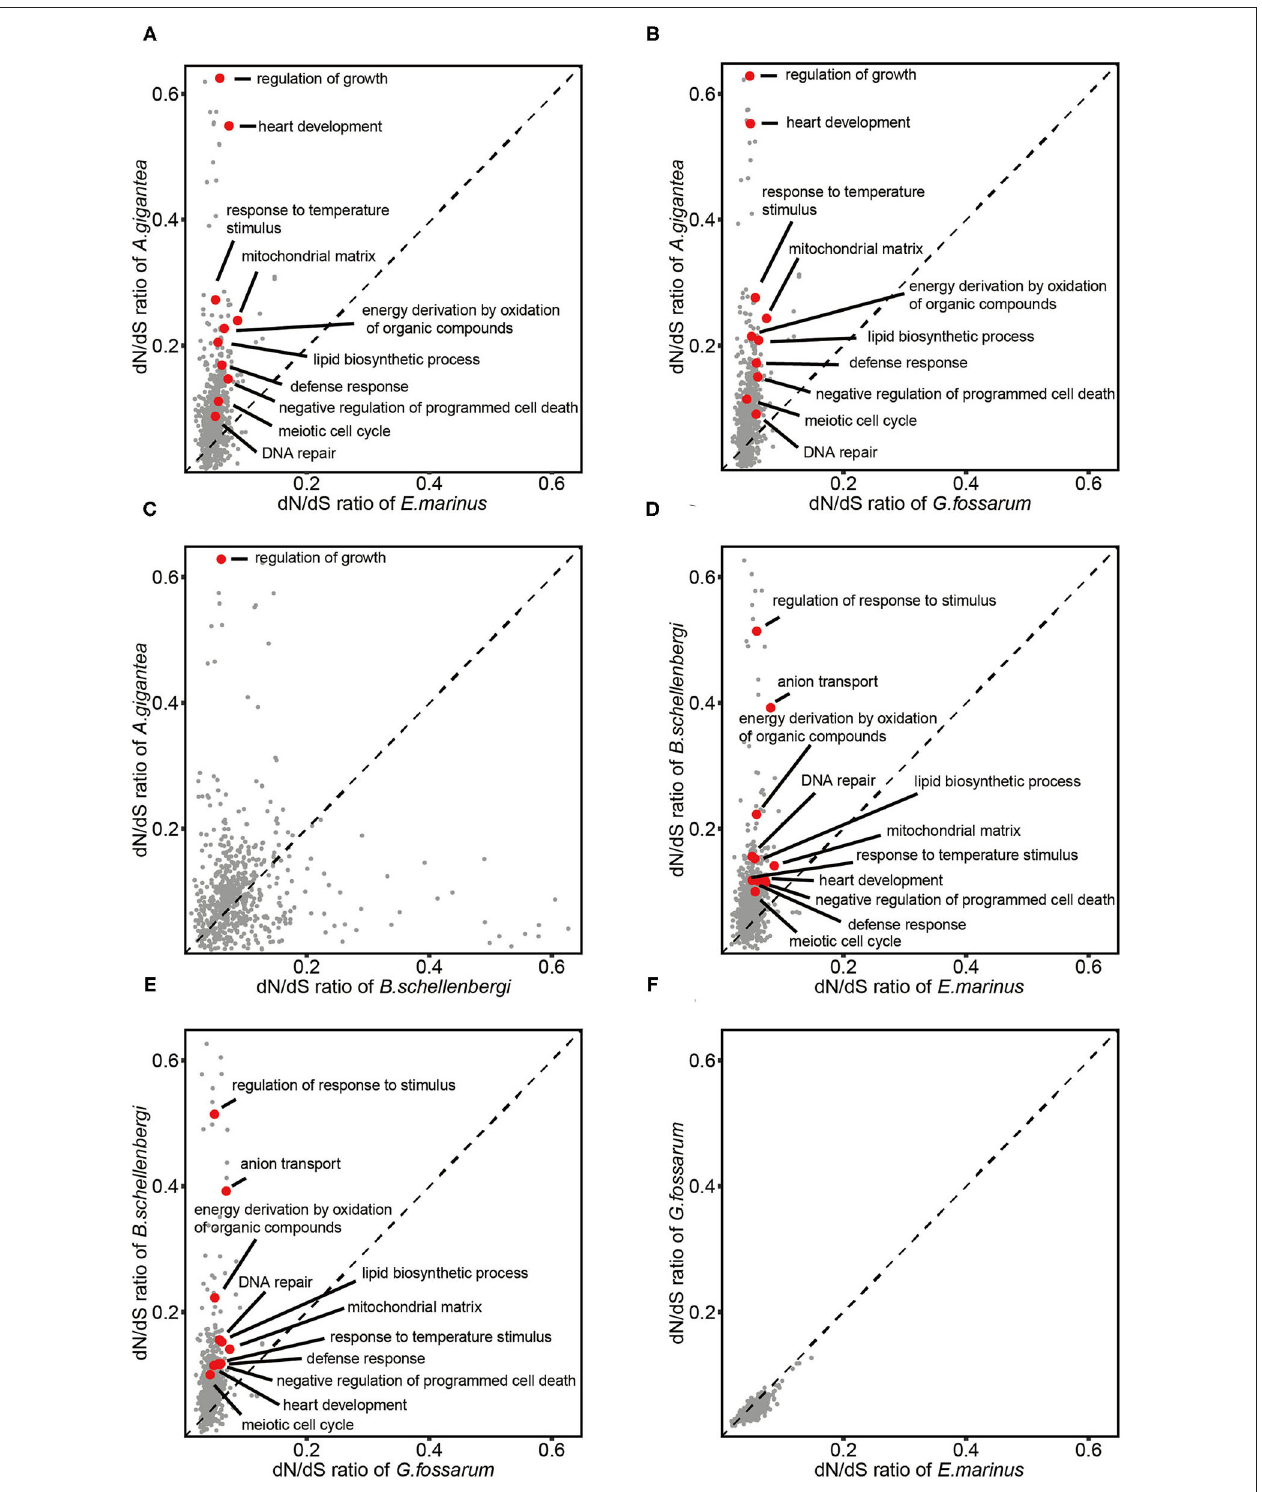
FIGURE 6 | Comparisons of dN/dS of GO terms between the two hadal amphipods ( A. gigantea and B. schellenbergi ) and two shallow-water amphipods ( G. fossarum and E. marinus ). The evolution rates of A. gigantea (A–C) and B. schellenbergi (D,E) were much faster than those of G. fossarum and E. marinus (F) on the whole. Several representative GO terms including “regulation of response to stimulus,” “mitochondrial matrix,” “DNA repair,” “meiotic cell cycle,” “lipid biosynthetic process,” and “defense response” (A,B,D,E) were selected and marked in red. Compared with the small-sized amphipod species ( B. schellenbergi , G. fossarum , and E. marinus ), the dN/dS of “regulation of growth” in the “supergiant” A. gigantea was significantly higher (A–C) . The comparison of shallow-water amphipods did not have these GO terms with significantly increased evolutionary rates (F) .